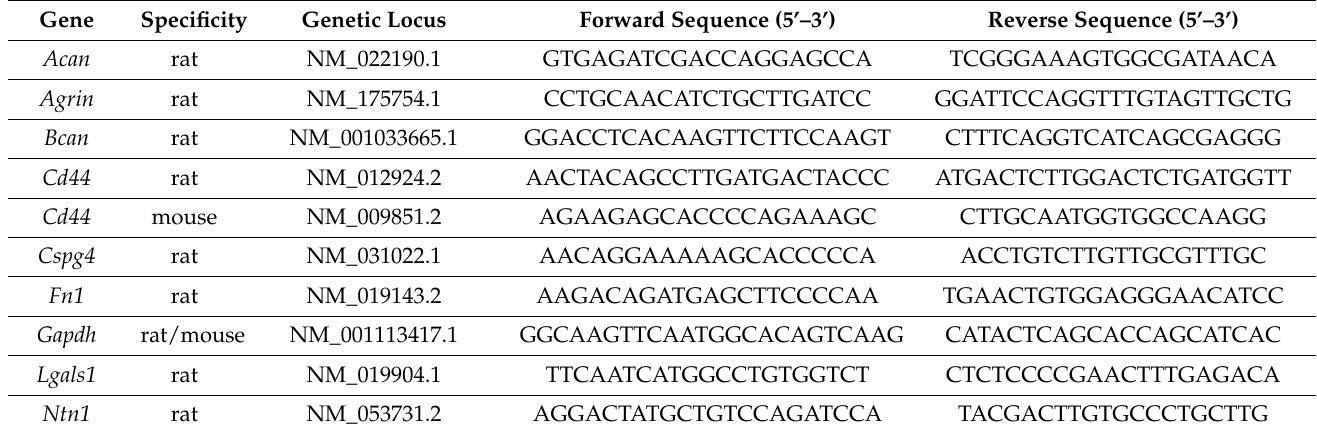
Table 1. Sequences and genetic loci of primers used for RT-qPCR